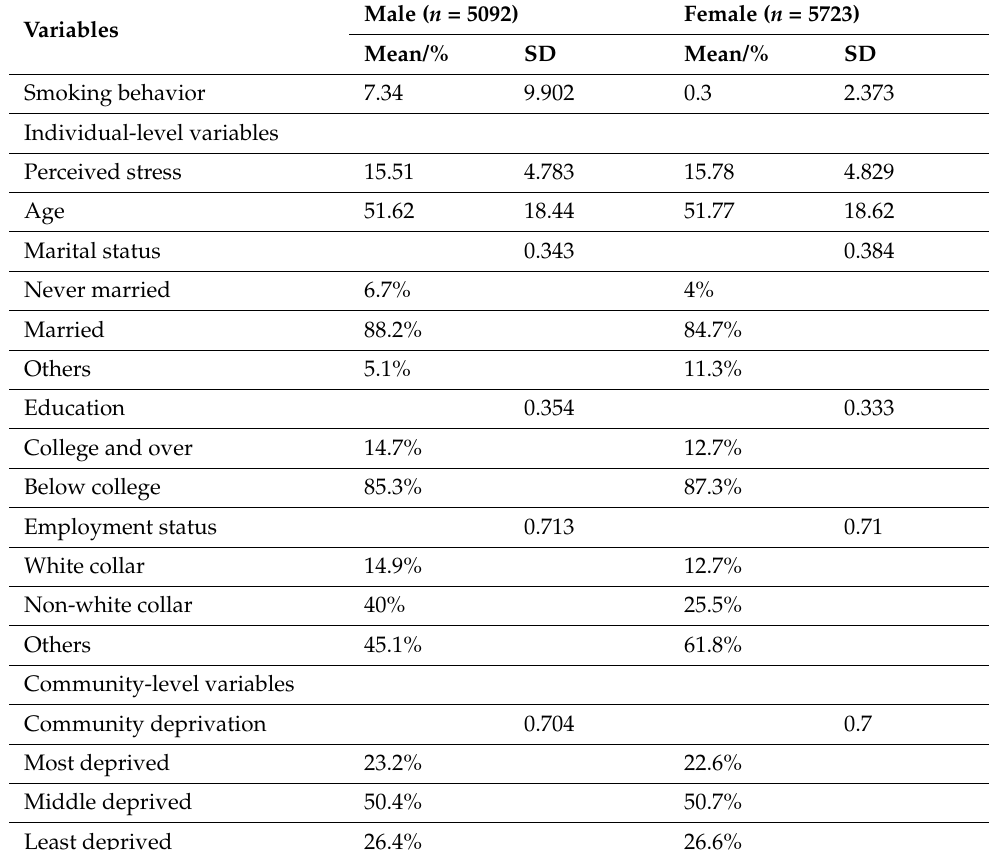
Table 2. Descriptive statistics for individual- and community-level variables used in models stratified by gender, restricted to ages over 21, CHNS,